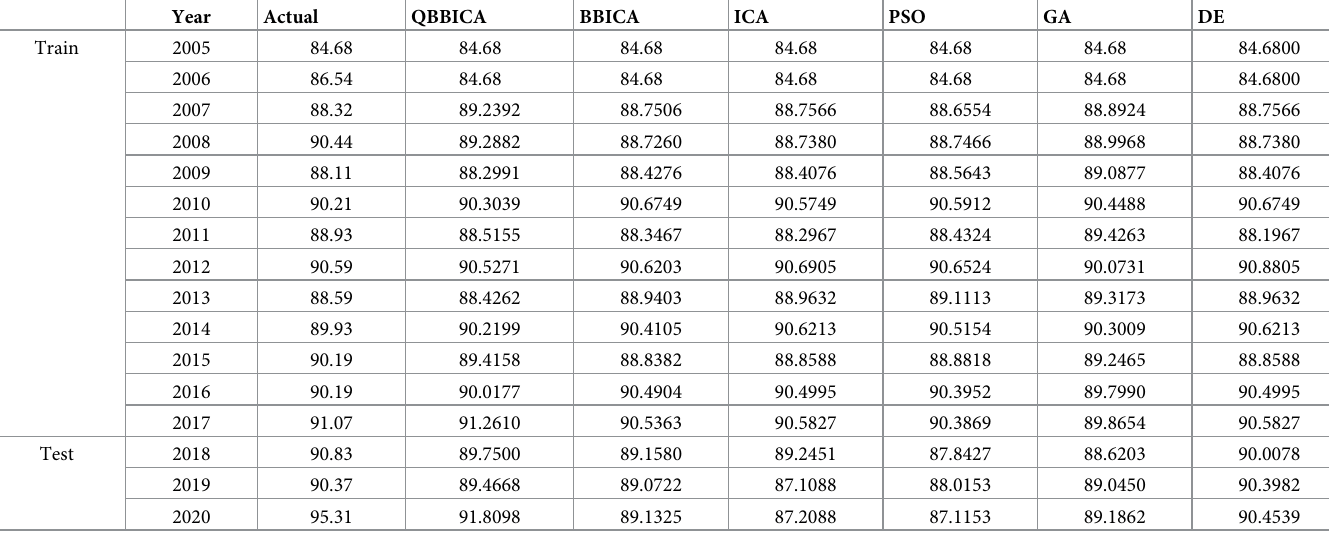
The larger the coefficient of efficiency is, the closer the predicted value is to the real value. Table 7. Prediction results of Sig-FCM trained by QBBICA, BBICA, ICA, RCGA, PSO and DE.